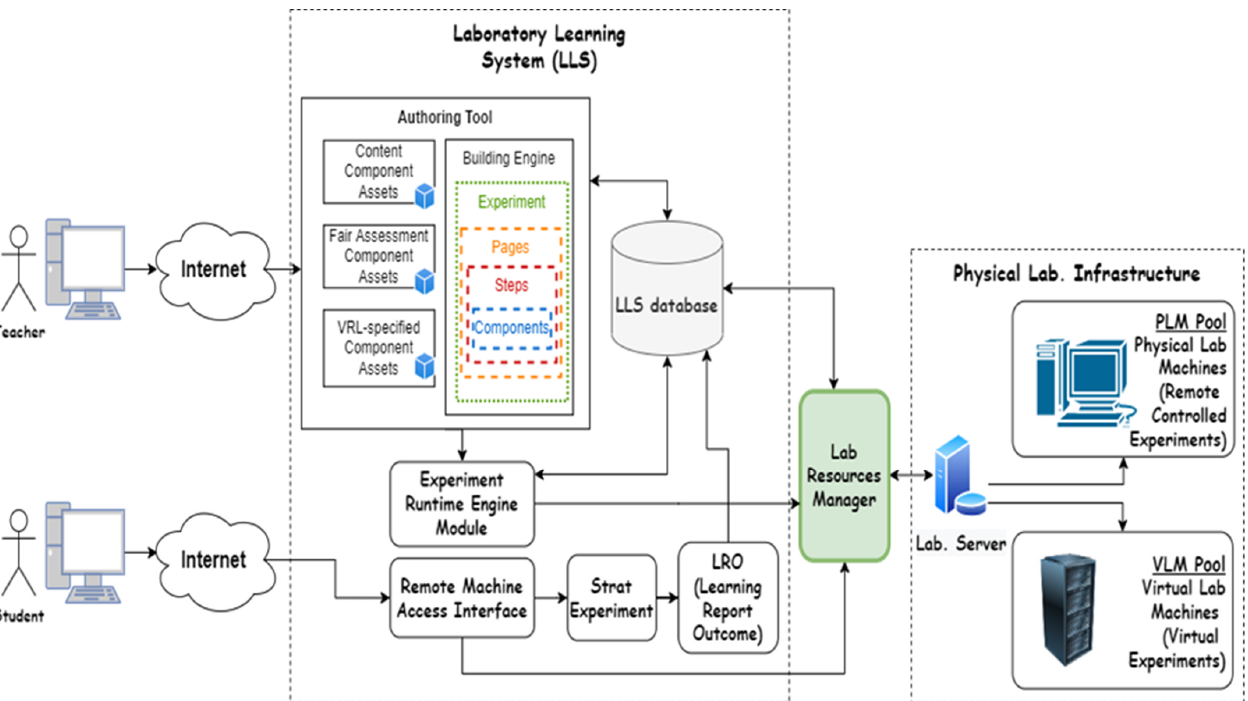
Figure 1. The architecture of the online Laboratory Learning System.